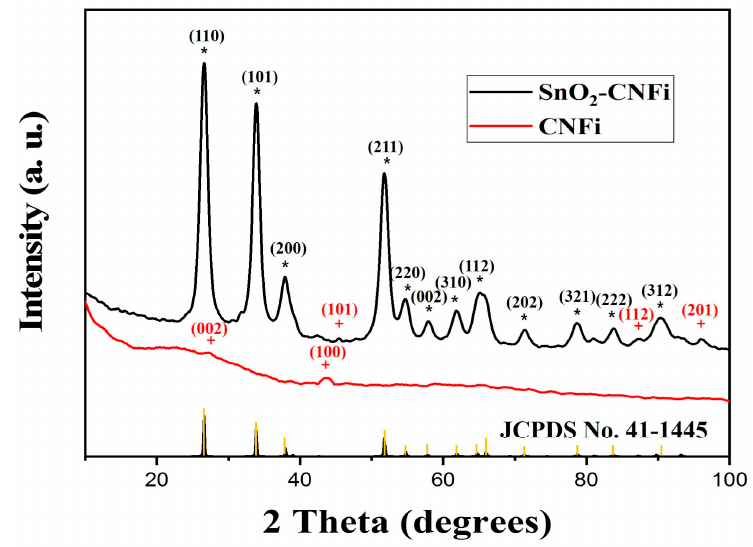
Figure 1. XRD profiles of CNFi and SnO 2 -CNFi. (*) for SnO 2 peaks, and (+) for C Figure 1. XRD pro fi les of CNFi and SnO 2 -CNFi. (*) for SnO 2 peaks, and (+) for C peaks.